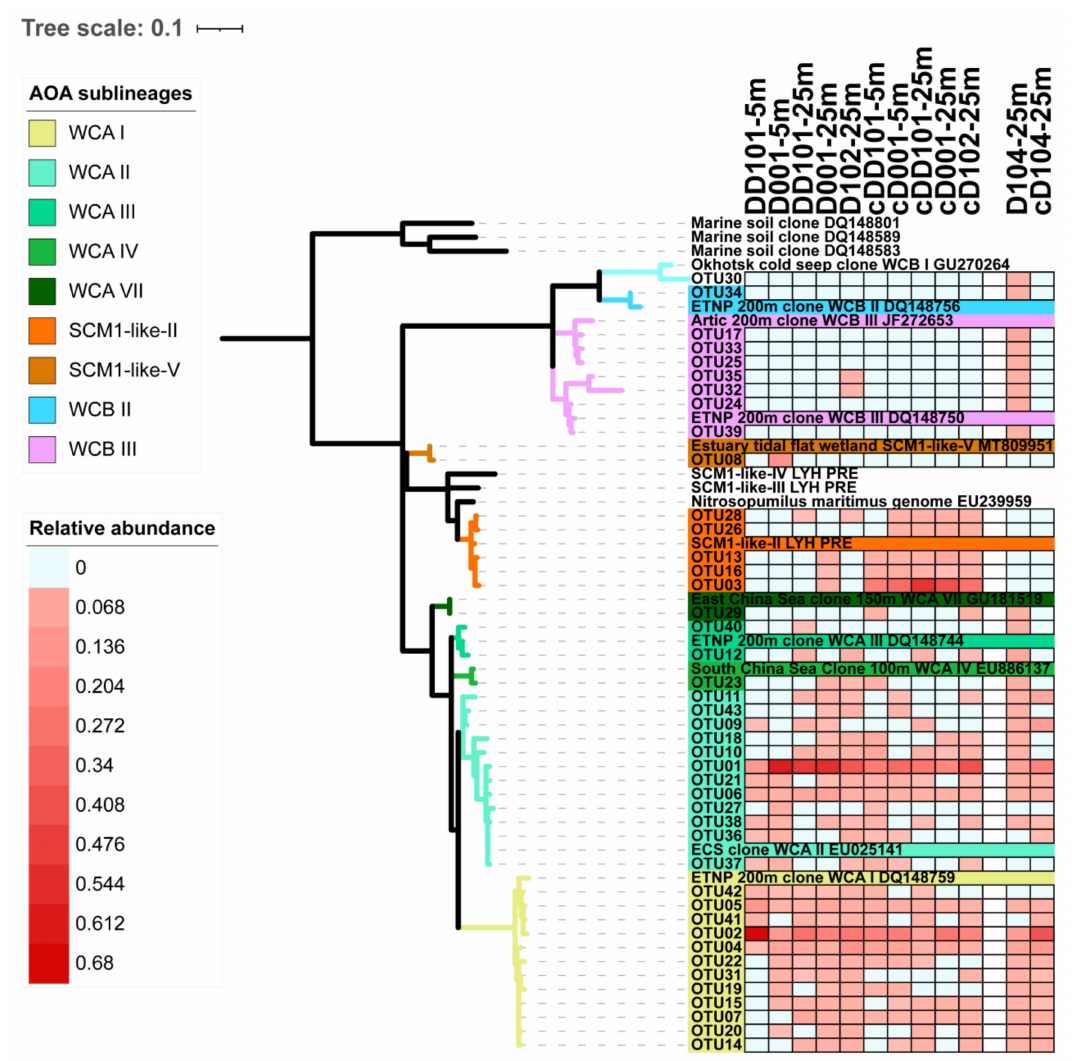
Figure 4. Phylogenetic maximum-likelihood tree of the AOA amoA gene sequences based on the top 43 OTUs obtained from samples collected in the eastern Hainan Island during summer. The associated heatmap was generated based on the relative abundance of top OTUs at the DNA and cDNA levels. Samples listed from left to right span from the upwelling region to the non-upwelling